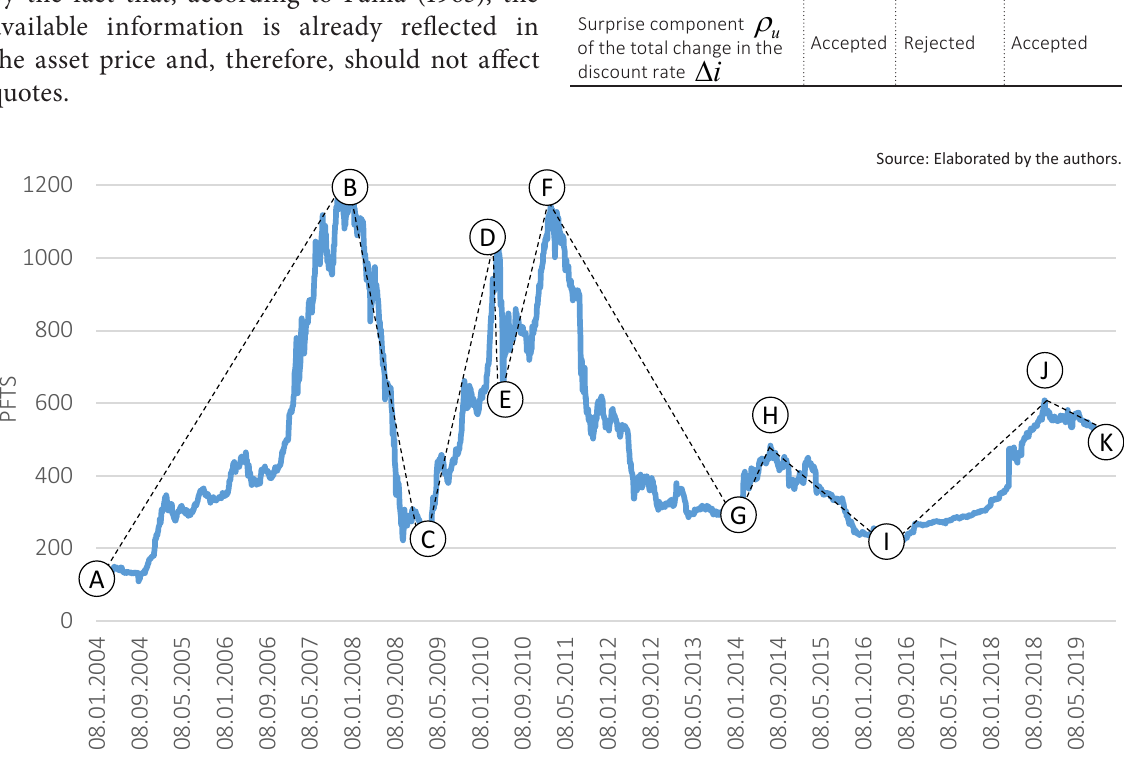
Figure 1. The cyclical fluctuations phases on the Ukrainian stock market (based on the PFTS stock index) from January 8, 2004 to December 27,